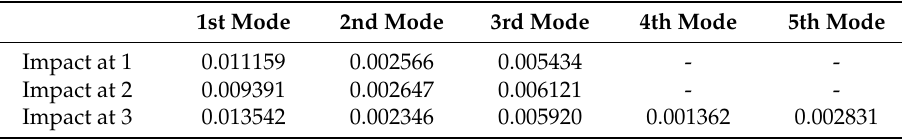
Table 3. Idenfified damping ratio by half-power